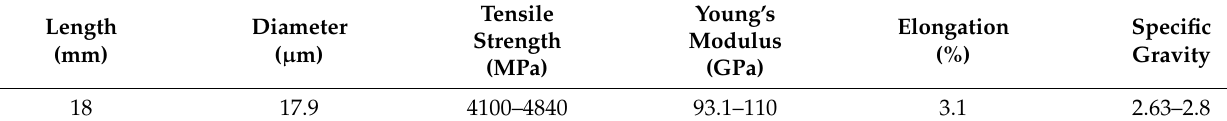
Table 3. Chopped Basalt Fiber Properties.